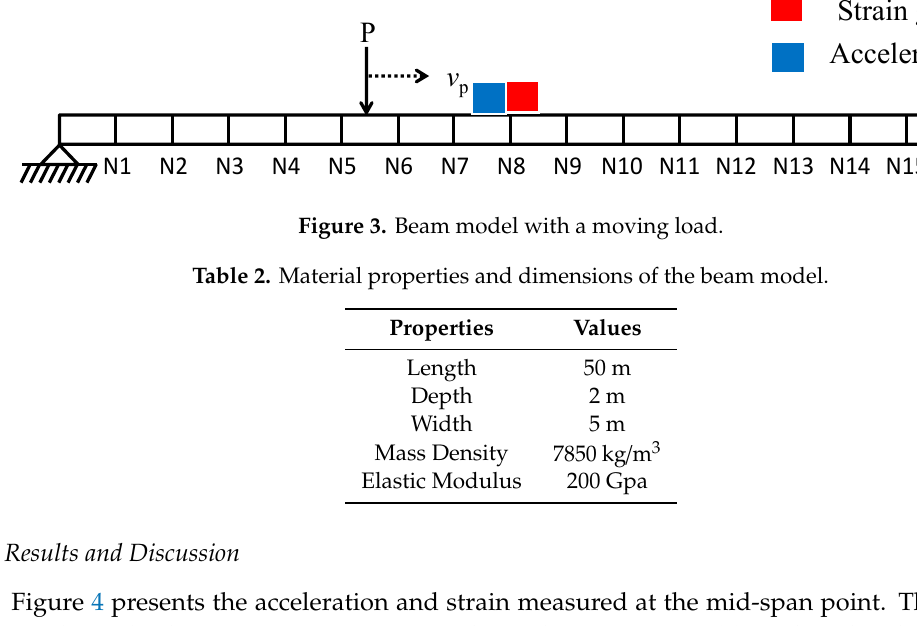
Figure 4. Numerical validation: ( a ) acceleration response and ( b ) strain response. An AKF was applied to fuse the acceleration with strain-based displacement data. The displacement calculated by the proposed method, acceleration-based displacement, and reference displacement are compared in Figure 5 in both the time and frequency domains. It should be noted that the vertical displacement at N8 was extracted numerically for the reference displacement and the acceleration-based displacement was obtained using the FIR filter proposed by Lee et al. [11].